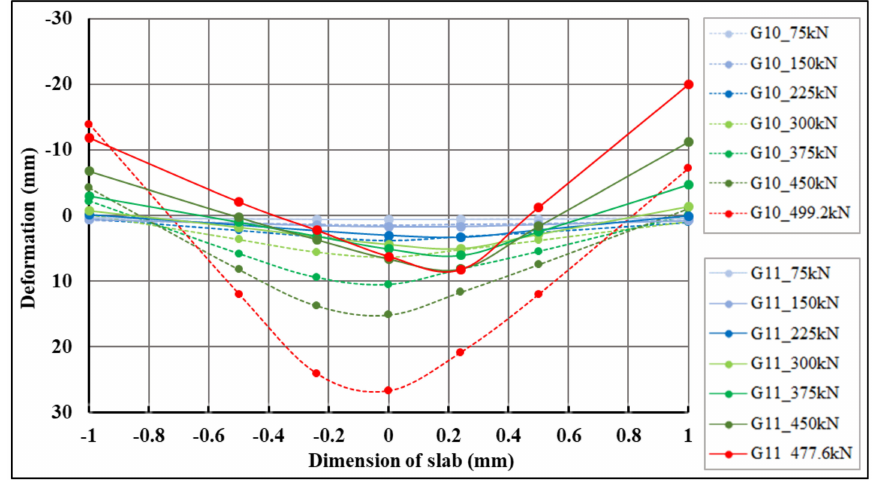
Figure 14. Comparison of 2D cross-deformation sections of centrically loaded slab G10 and eccentri- cally loaded slab G11 for sensors 06–22. Table 6. Deformation of centrically loaded slab G10 and eccentrically loaded slab G11 for track sensors 06–22.